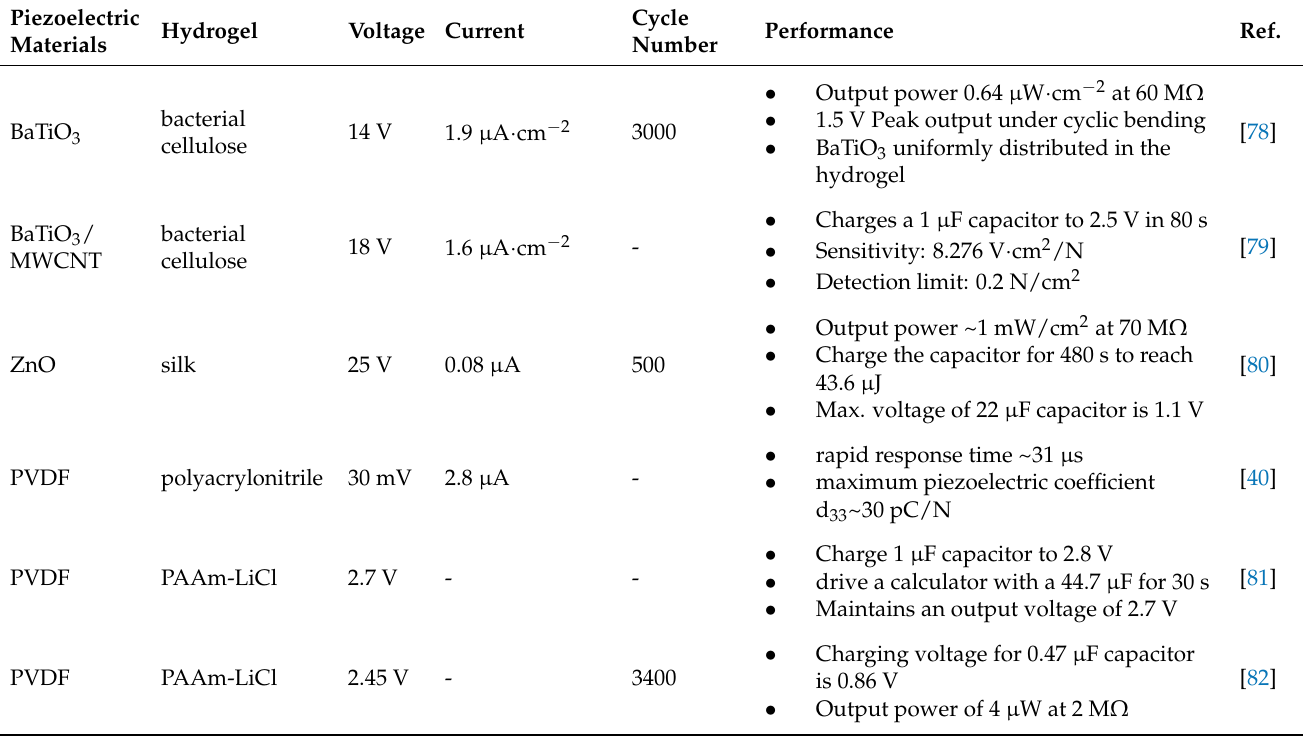
Table 2. Hydrogel-based piezoelectric devices for energy harvesting applications, different piezoelec- tric materials and hydrogels, the critical parameters, and related performance.